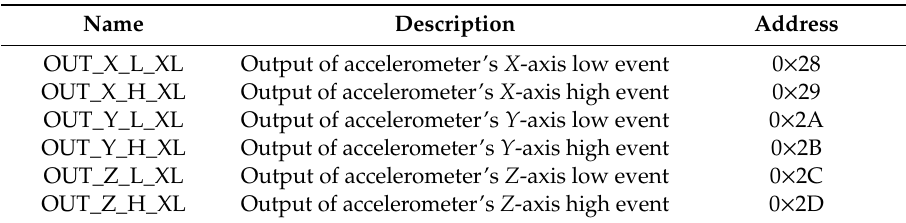
Table 3. Register mapping for LSM9DS1